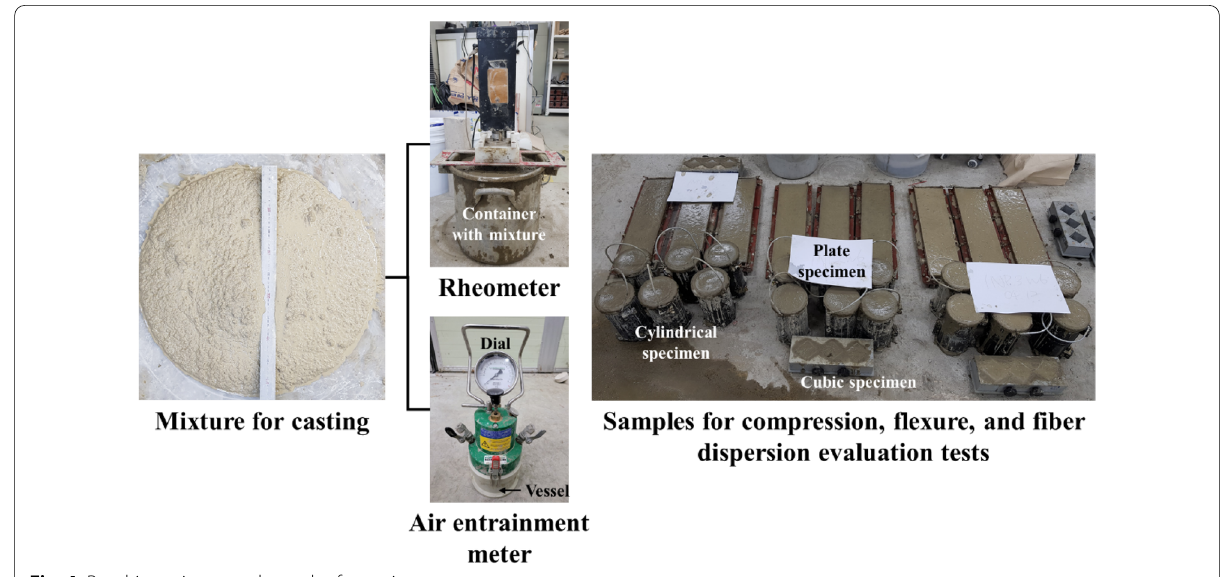
Fig. 4 Resulting mixture and samples for testing